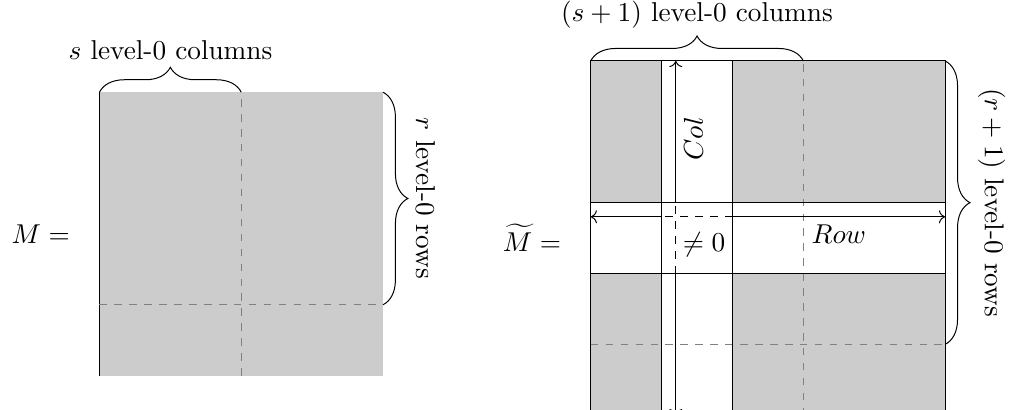
Figure 1 . Visualisation of the matrices M and f M